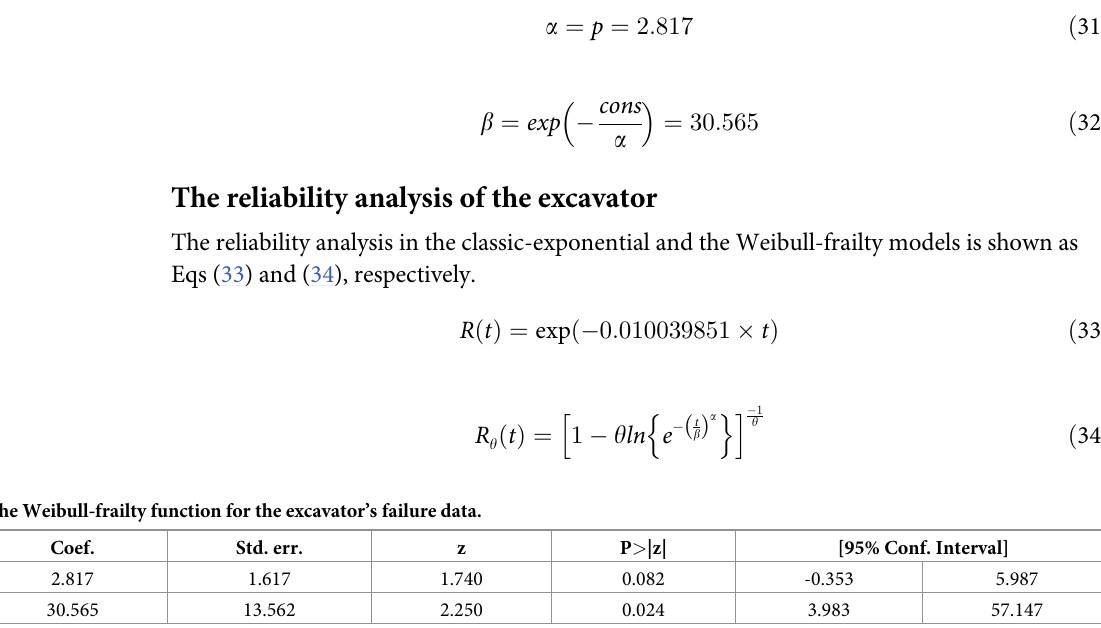
Eqs (31) and (32) were applied to achieve the parameters of α and β . To unify and convert these parameters in a general form of the Weibull function (Table 5), results from Table 4 were used to achieve the values of 2.817 and 30.565 for the parameters of α and β , respectively.